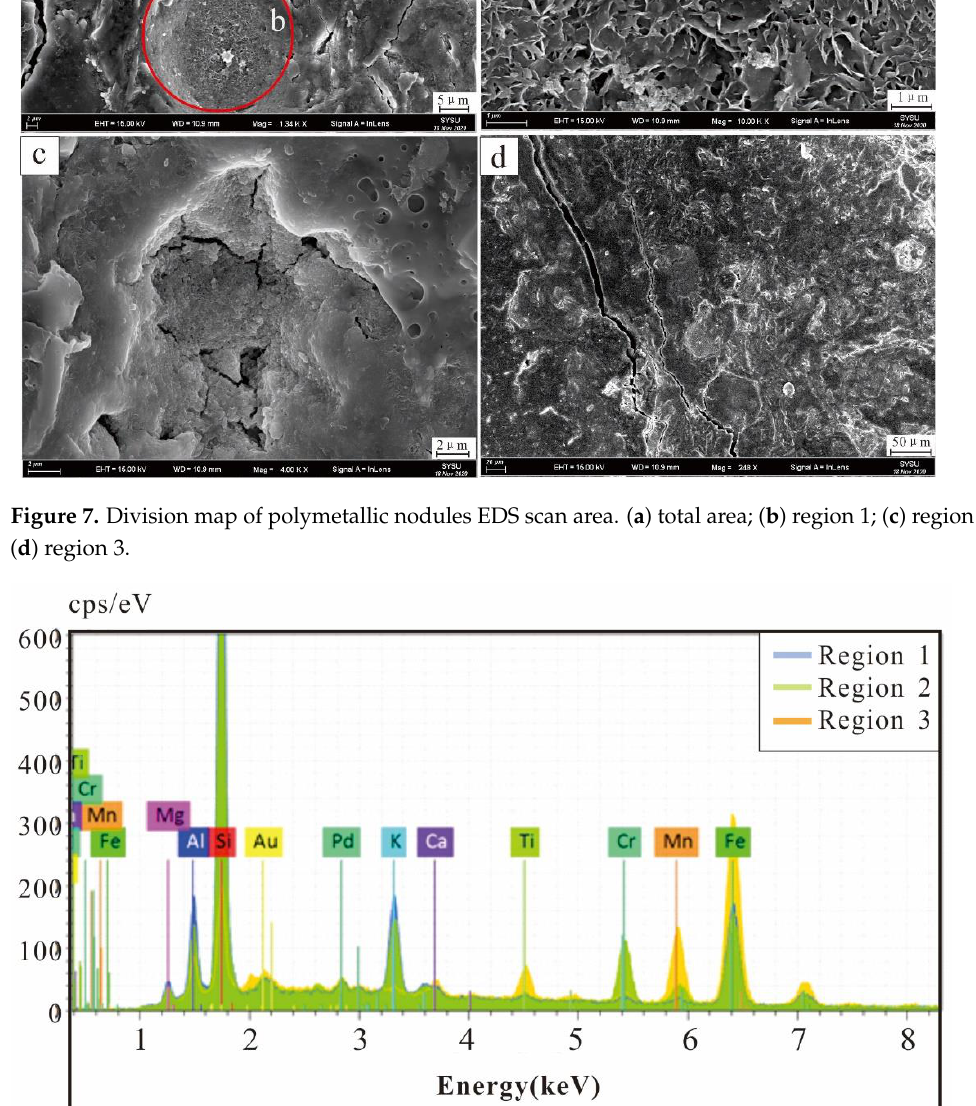
Figure 8. EDS area scan results of the core in polymetallic nodules.